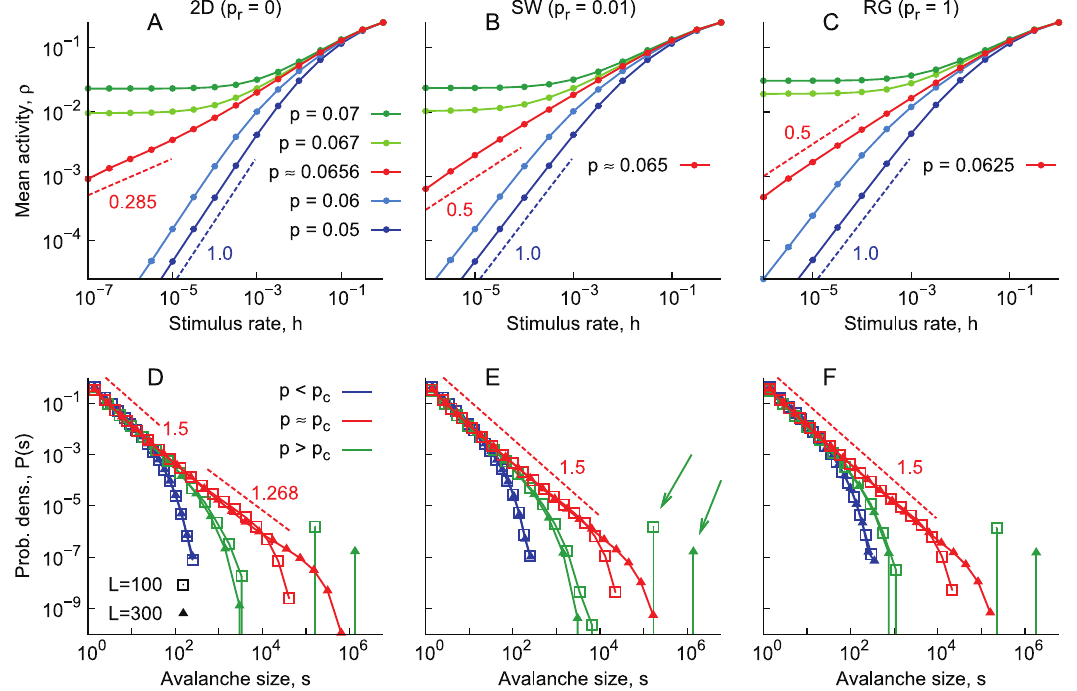
Figure 2. Determining the critical point. A) Response curves for the two-dimensional network, with varying transmission probability p . Blue curves are obtained from subcritical systems, with the dashed blue line indicating a r ~ h 1 relationship. Green curves are obtained from supercritical systems, whereas the red one is obtained from a critical system. The red dashed line indicates a r ~ h 0 : 285 relationship. B) Same as in A, but for a small- world network. The red dashed line here indicates a r ~ h 0 : 5 relationship. C) Same as in B, but for a random network. D) Avalanche size distributions for the two-dimensional network. Different p (same color code as in top panels) and system sizes N ~ L | L (symbols) are shown. Dashed lines represent exponents of 1.5 (top line) and 1.268 (bottom line). E) Same as in D, but for the small-world network. The dashed line represents an exponent of 1.5. Green arrows highlight the infinite avalanches observed in supercritical systems (see Results). F) Same as in E, but for the random network.